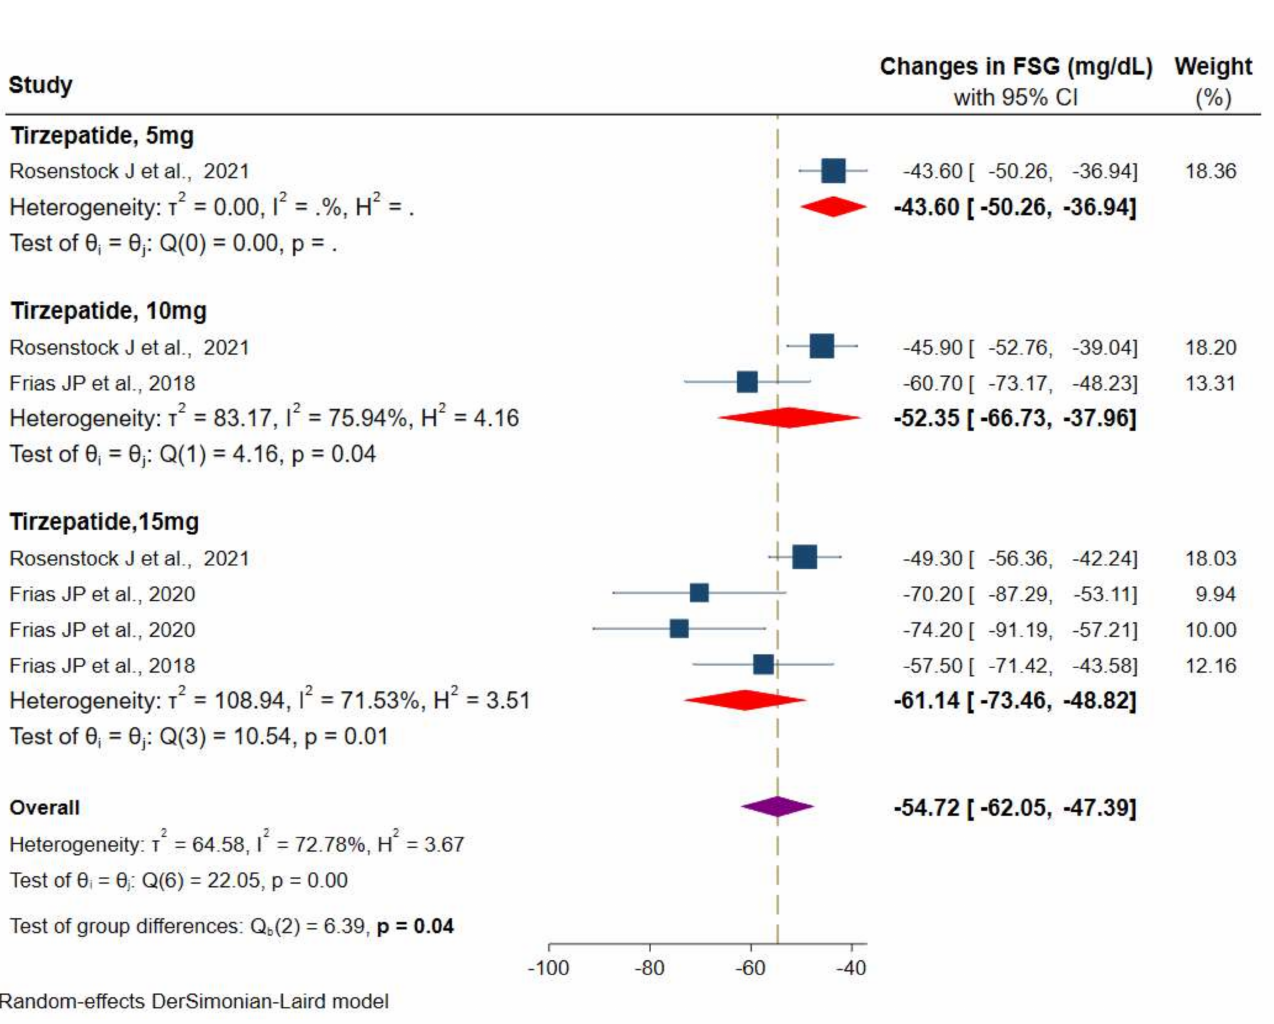
Figure 5. Effect of once-weekly tirzepatide on fasting serum glucose levels